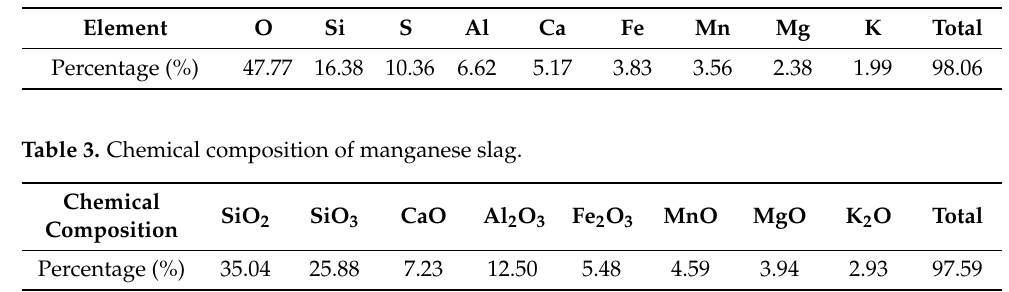
Figure 1. XRD pattern of manganese slag.